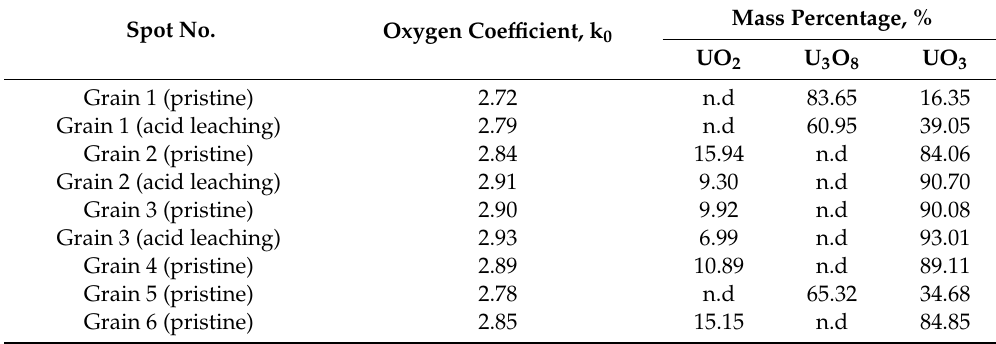
Table 2. Summary of oxygen coe ffi cient k O and UO 2 + x oxide mass percentage of uraninite (%; n.d = not